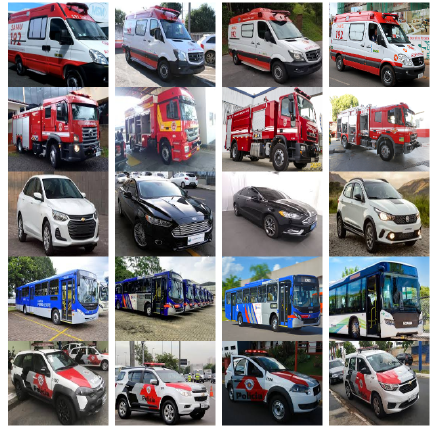
Figure 2. Database images created and their subcategories